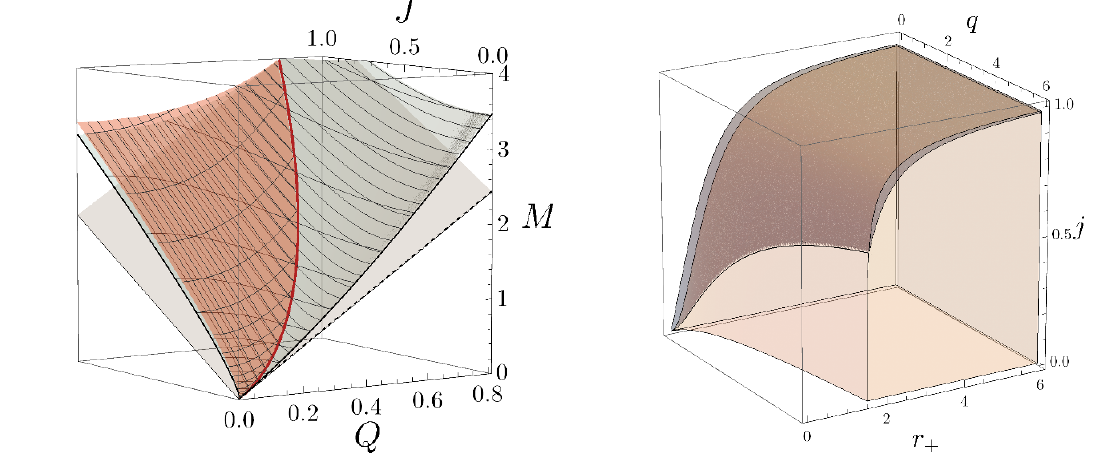
Figure 2 . Left : phase diagram for the regular CLP black hole solutions, showing possible Q , M and J values. The grey plane shows the BPS limit M = 2 J + 3 Q , the blue plane is the extremal limit with T = 0. The red line shows Real-Gutowski holes, which are extremal BPS solutions, and lie on the intersection of the extremal and BPS planes. The orange plane shows the (cid:10) H = 1 limit for regular black holes with T > 0. Such black holes exist above the extremal plane, and regular solutions with (cid:10) H > 1 exist only between the orange and blue planes. For J = 0, we recover RNAdS solutions, and for Q = 0 we recover MPAdS holes. Right : allowed parameter space for regular CLP black holes. It is bounded by the extremal surface, which also guarantees a non-negative entropy. The grey region on top shows the moduli space with (cid:10) H (cid:21) 1. The Gutowski-Reall black holes are the curve on the front left face, where the gray region meets the orange